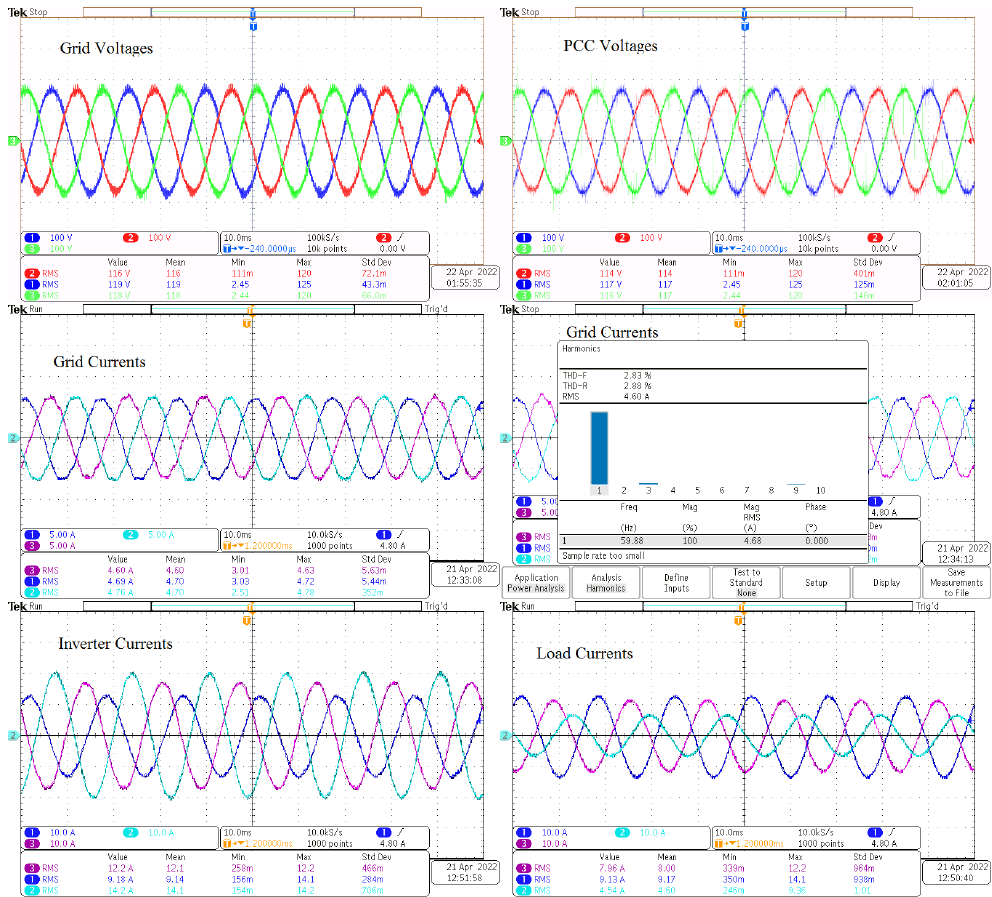
Figure 17. Experimental results at P = 1.5 kW, Q = − 500 var using Tektronix MDO3024 oscilloscope.